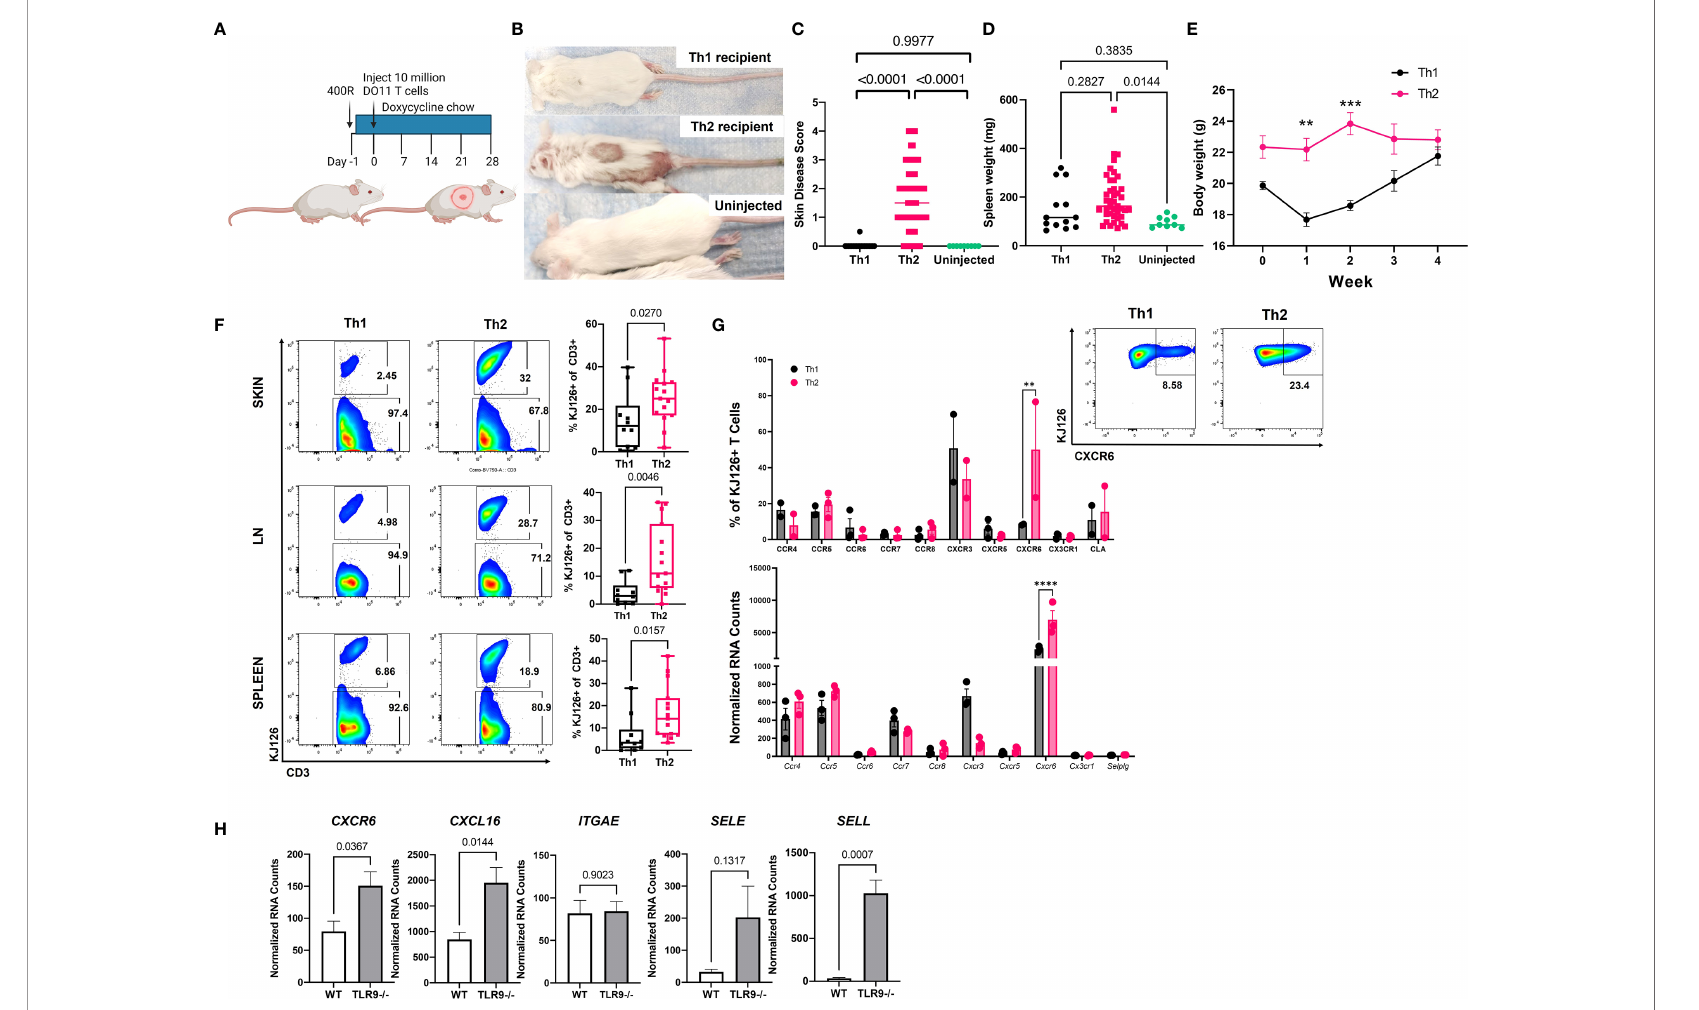
FIGURE 2 | Injection of Th2, but not Th1, induces lupus-like skin lesions in mice. (A) Timeline for the initial induction of skin lesions created with BioRender.com. (B) Representative images of mice injected with Th1 or Th2 cells, compared to uninjected control. (C) Skin disease scores, (D) spleen weights and (E) body weights of mice (n=15 Th1, 45 Th2 and 9 uninjected mice pooled from 4 separate experiments, one and two way ANOVAs signi fi cant as indicated.) (F) T cell engraftment assessed by fl ow cytometry analysis of cell suspensions recovered from skin, lymph node (LN) and spleen tissue (n=10 Th1 and n=15 Th2 mice pooled from 2 separate experiments; two-tailed students t tests signi fi cant as indicated). (G) . Assessment of chemokine receptor expression by RNA (top) and fl ow cytometry (bottom) of in vitro activated Th1 and Th2 cells. (H) Reanalysis of gene expression in total skin of TLR9-/- versus WT control mice from Mande et al., (5) to assess ligand expression. ** p <0.01, *** p <0.001 and **** p